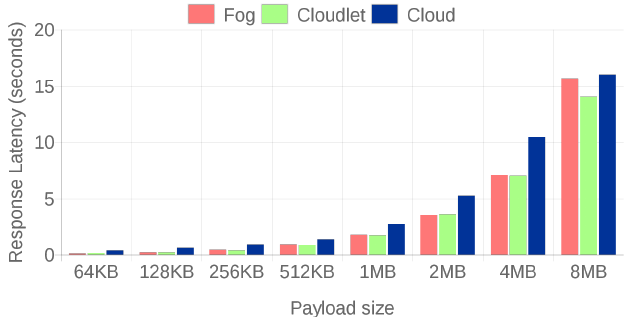
Figure 9. Response latencies for 64KB to 8MB file sizes.